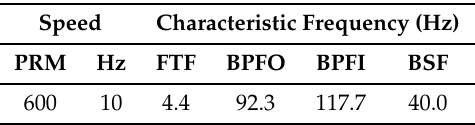
Table 1. Summary of the characteristic frequencies of the rolling element used for the experiment. Here, FTF stands for Fundamental Train Frequency, BPFO and BPFI are Ball Pass Frequency of Outer and Inner race respectively; and BSF is Ball Spin Frequency.